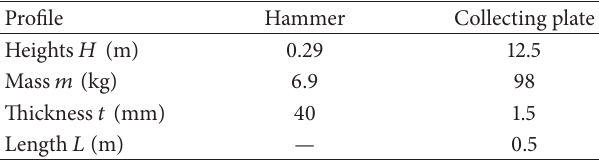
Figure 5: Rapping system, collecting plates (FLS Group, Inc.) [9]. Table 1: Profile parameters of collecting rapping